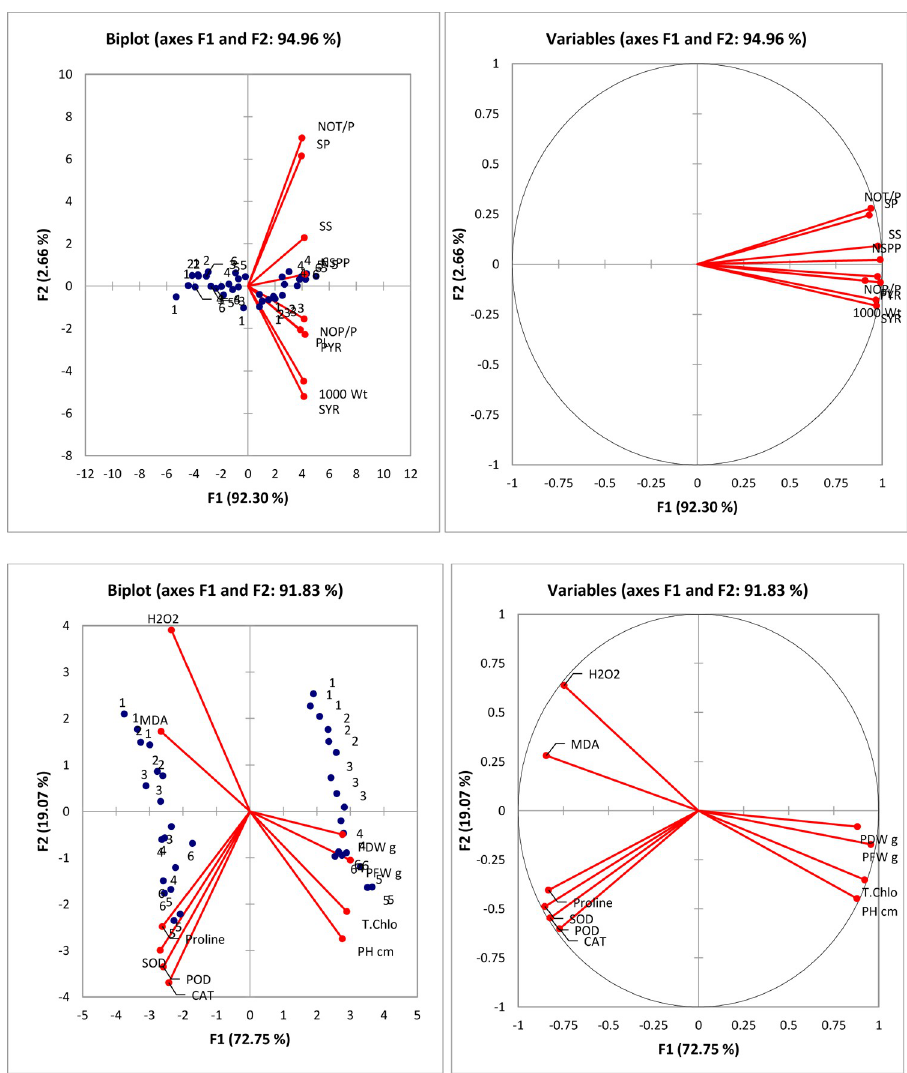
Fig 6. PCA analysis showing correlations among studied parameters of water-stressed rice plants primed with ZnONPs. NOT/P Number of Tiller per Plant, NOP/P Number of panicles per plant, PL Panicle length, NSPP Number of Spikelet per Panicle, H2O2 Hydrogen peroxide, MDA Malandialdehyde, SYR Straw Yield of Rice, PYR Paddy Yield of Rice, SS Seed Starch, SP Seed Protein, PRO Proline, CAT Catalase, 1000 Wt. 1000 Paddy Weights, PH Plant Height, PFW Plant Fresh Weight, PDW Plant Dry Weight, SOD Superoxide Dismutase, POD